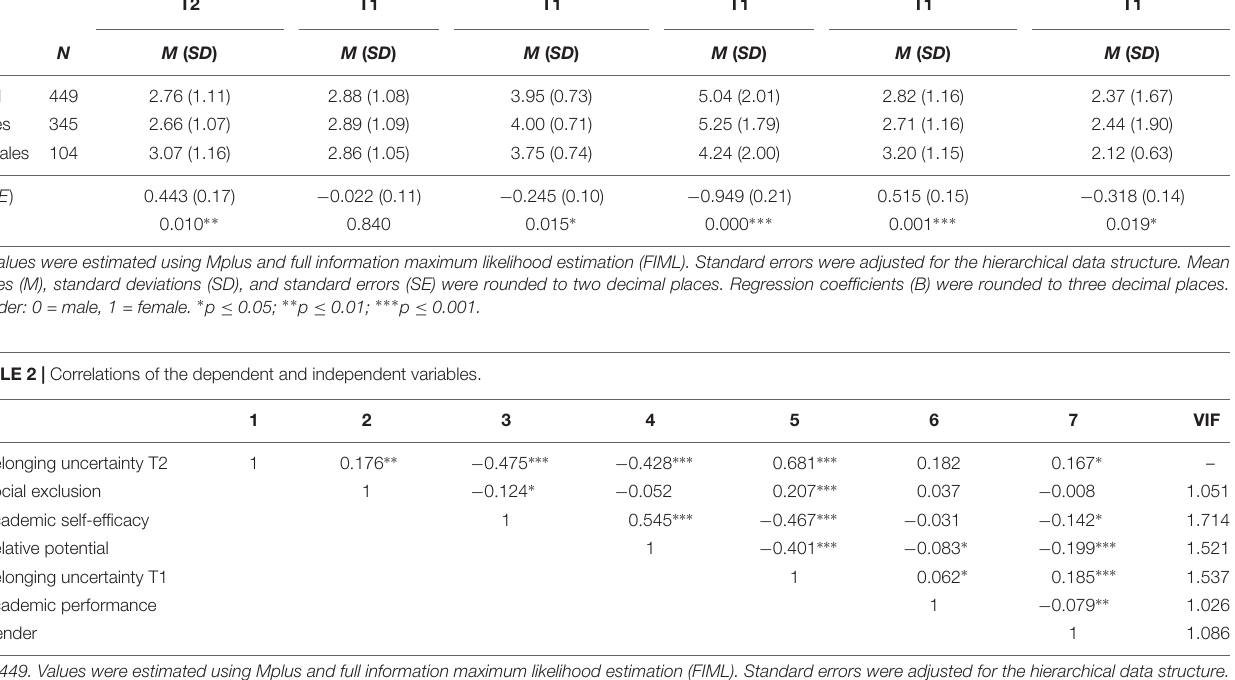
TABLE 1 | Means, standard deviations, and mean comparisons by gender of the dependent and independent variables. Belonging uncertainty Social exclusion Academic self-efficacy Relative potential Belonging uncertainty Academic performance T2 T1 T1 T1 T1 T1